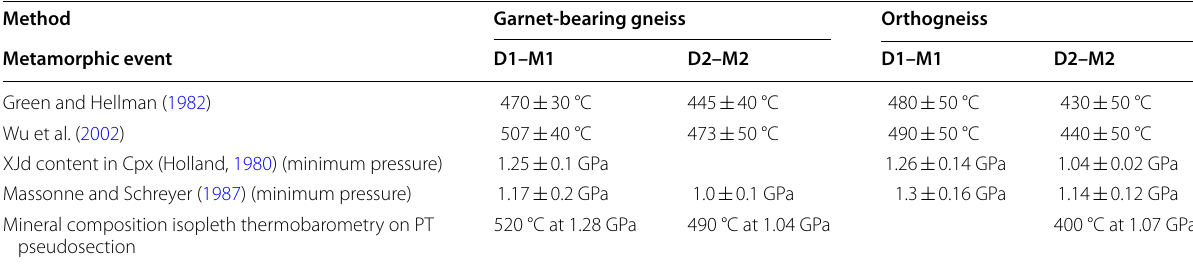
Table 8 Thermobarometric estimates obtained using independent thermometers and barometers and referred to successive metamorphic events (D1–M1 and D2–M2)